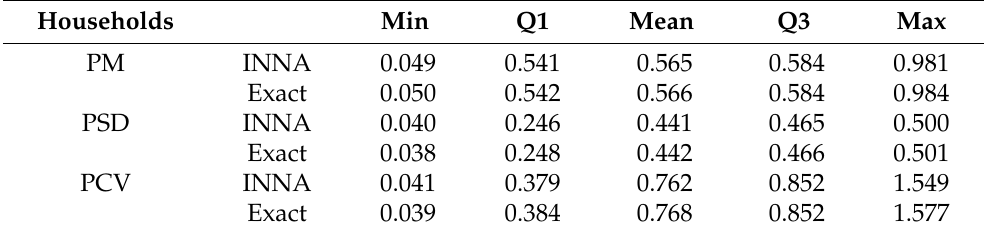
Table 4. Comparison of posterior inference about the finite population proportions using the five- number summaries at the household